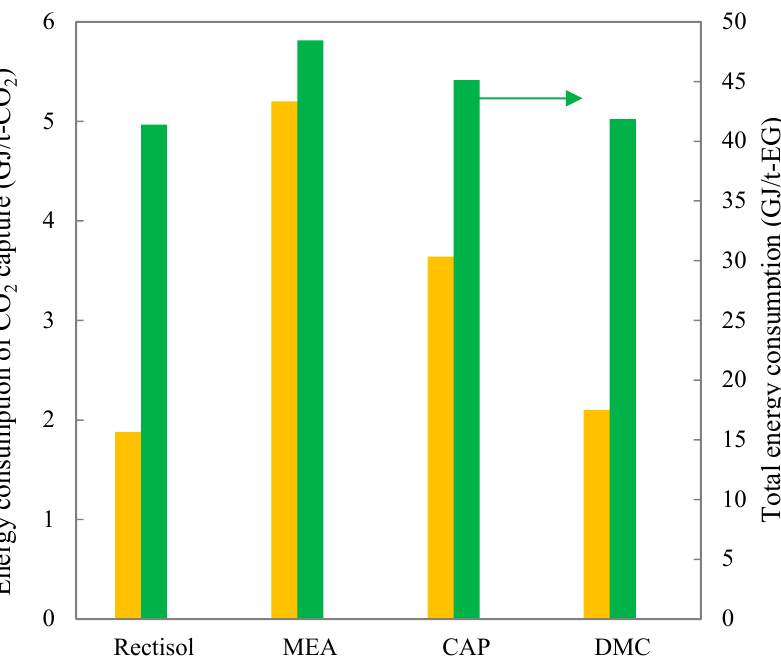
Figure 8. Energy consumption of CTEG process with different CO 2 capture technologies.